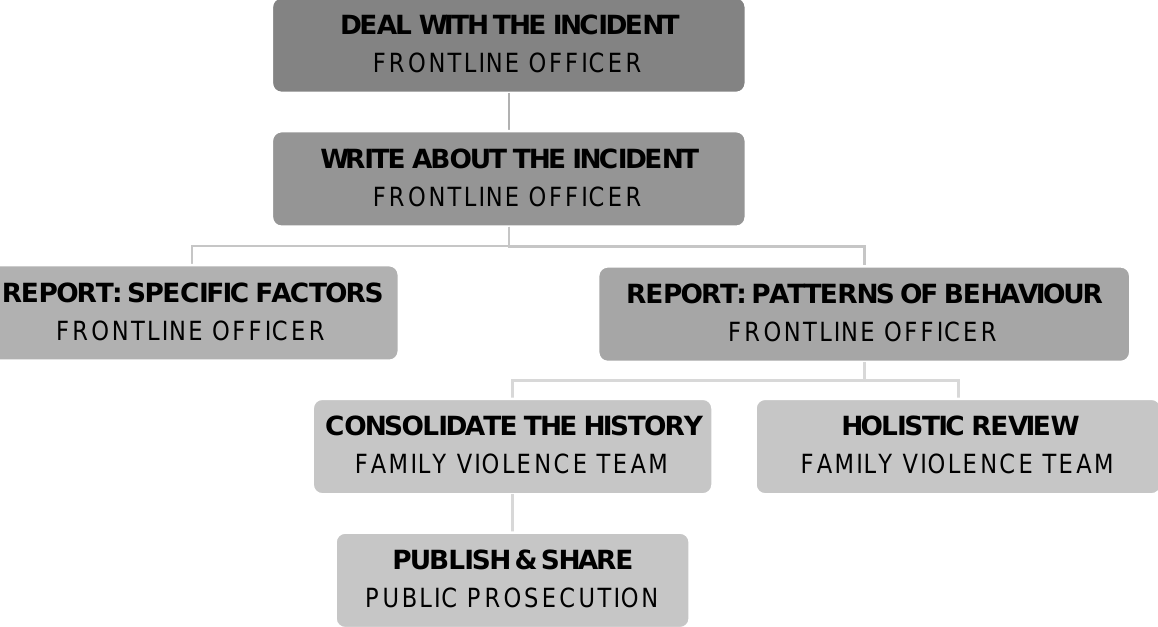
Figure 2: Stages of cyberstalking